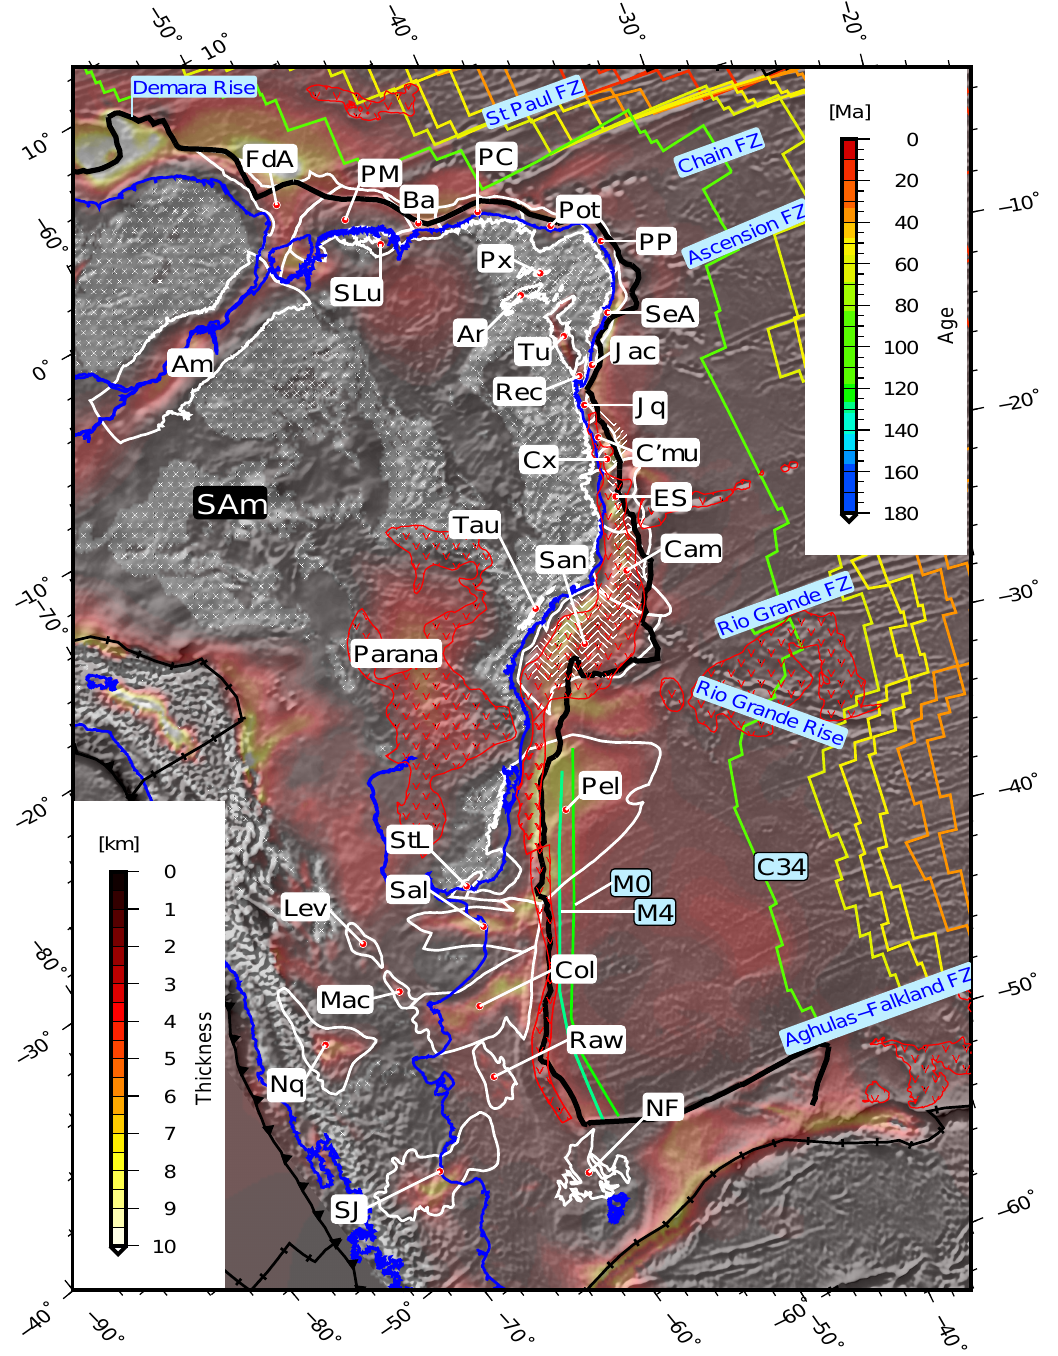
Fig. 8. Oblique Mercator map of present-day South America (SAm), with onshore topography (ETOPO1; Amante and Eakins, 2009), offshore free-air gravity (Sandwell and Smith, 2009), both greyscale, and gridded sediment thickness (Exxon Production Research Company, 1985) superimposed. Map legend as in Fig. 5. White polygons denote sedimentary basins (N to S): FdA – Foz do Amazon; PM – Para-